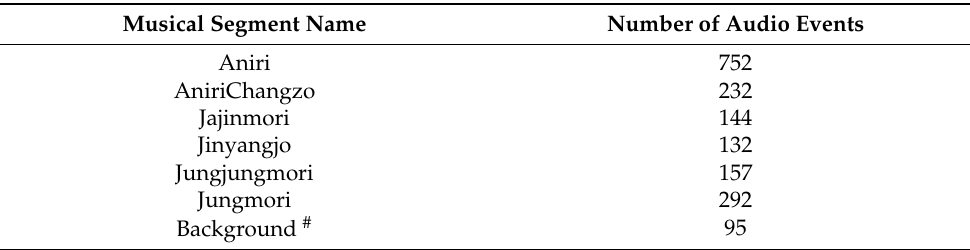
Table 2. Pansori rhythm segmentation dataset. Events are the singing mods presented in the whole